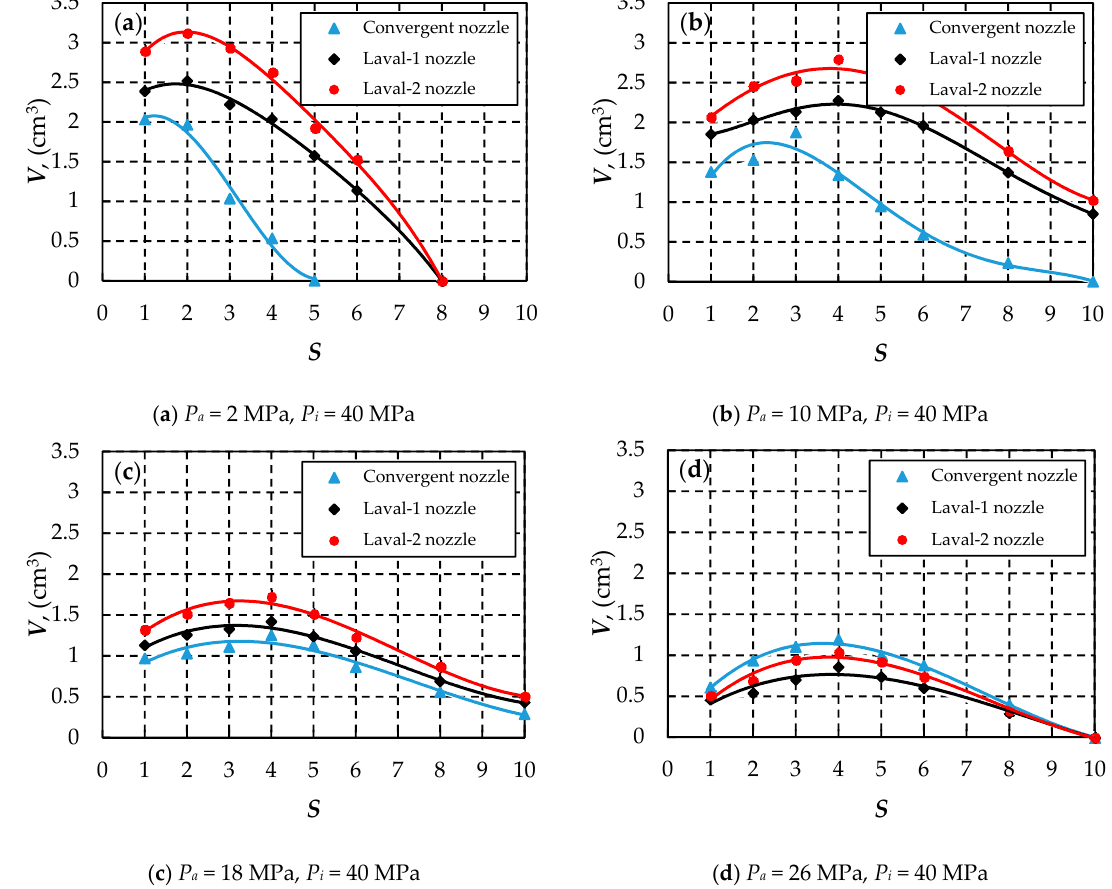
Figure 7. Effect of nozzle configuration on rock erosion volume of the SC-CO 2 jet under different ambient pressures and constant inlet pressure: ( a ) 2 MPa; ( b ) 10 MPa; ( c ) 18 MPa; ( d ) 26 MPa.